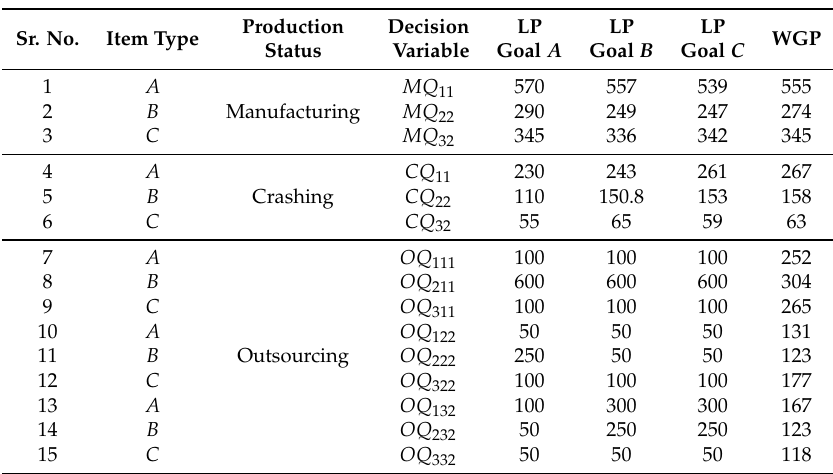
Table 10. Optimal solution of the mathematical